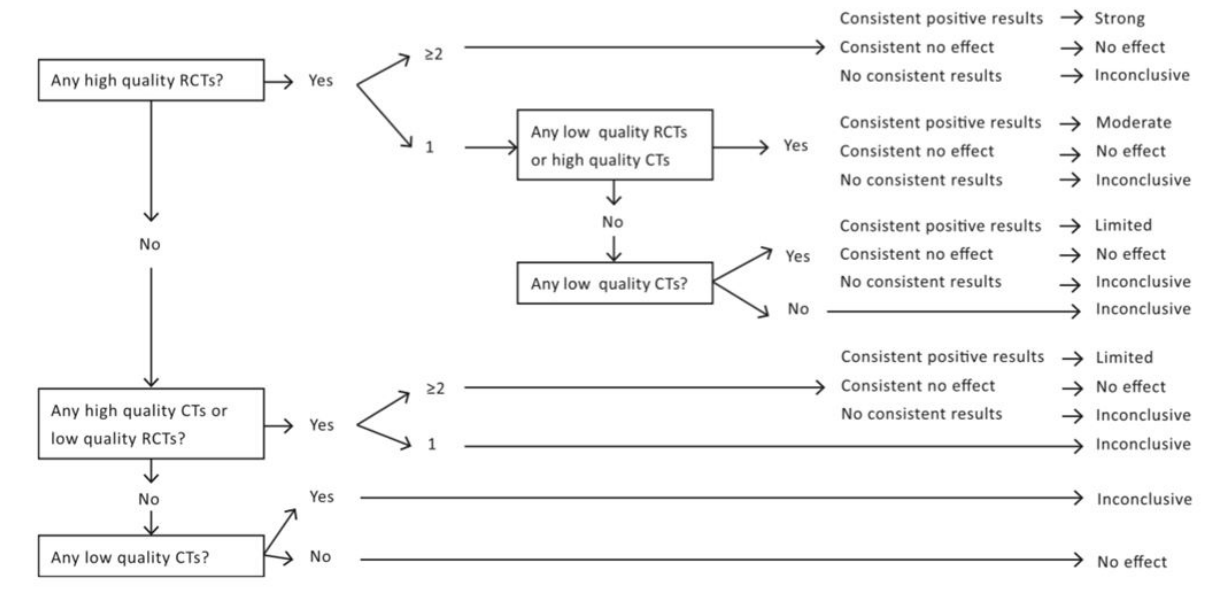
Figure 1. Flowchart of the decision-making process for levels of evidence, based on study design and methodological quality. CT: controlled trial; RCT: randomized controlled